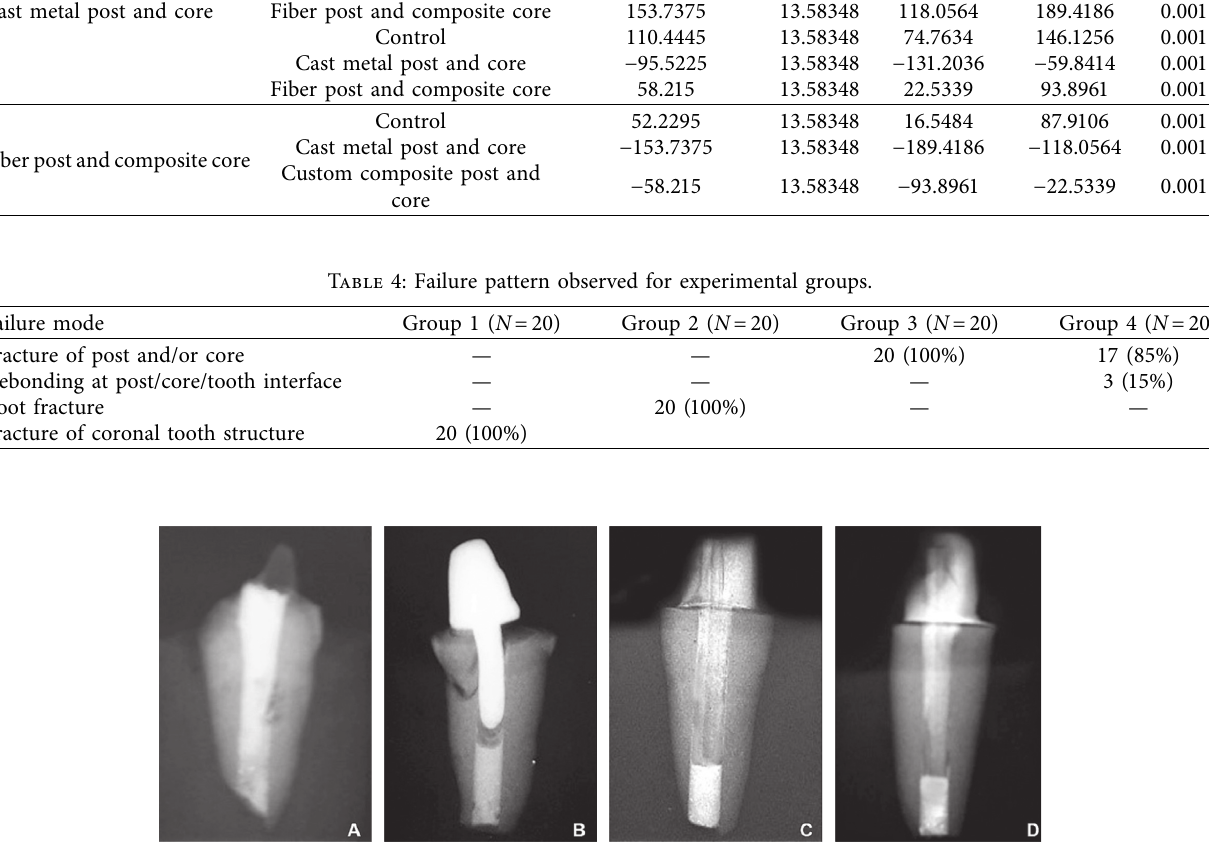
Figure 3: (a) Radiograph indicating failure pattern of: control group. (b) Cast metal post and core. (c) Customized composite post and core. (d) Fiber post and composite